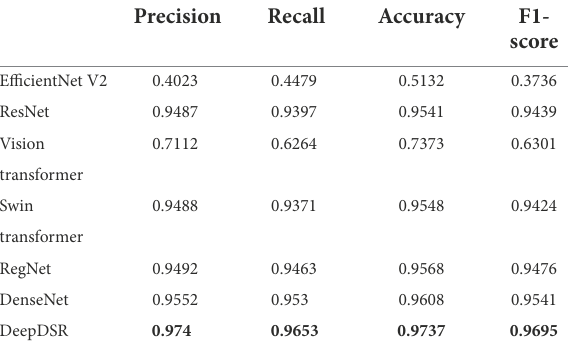
TABLE 7 The performance of DeepDSR and other models for three- classification problem.